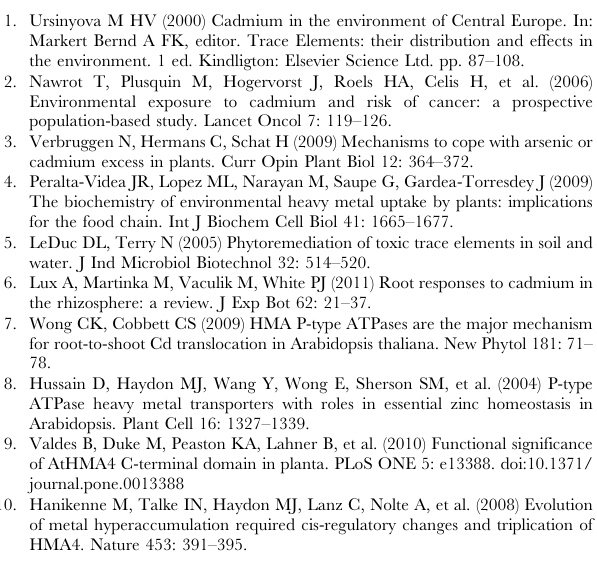
Figure S2 Comparison of the leaf Cd concentration in 14 A. thaliana accessions grown on different growth medium. Data represent the mean leaf Cd concentration 6 standard errors (n= 4 for plants grown on solidified K MS media and 6–12 for plants grown on potting mix soil). Table S1 Protein coding sequence variation of HMA3 and leaf Cd concentration in 149 A. thaliana accessions. Table S2 Primers used in this